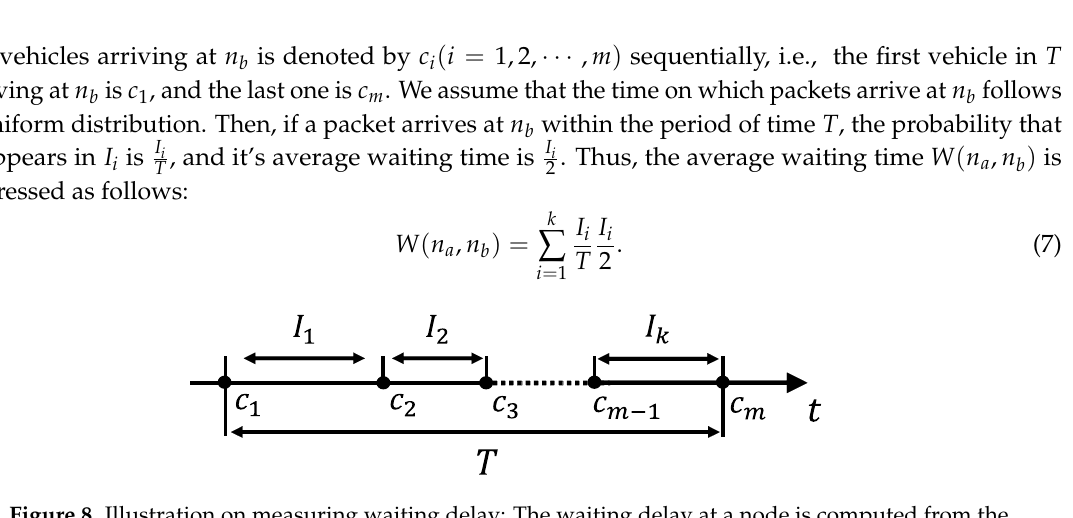
Figure 8. Illustration on measuring waiting delay: The waiting delay at a node is computed from the arriving time of m vehicles within the time period of T